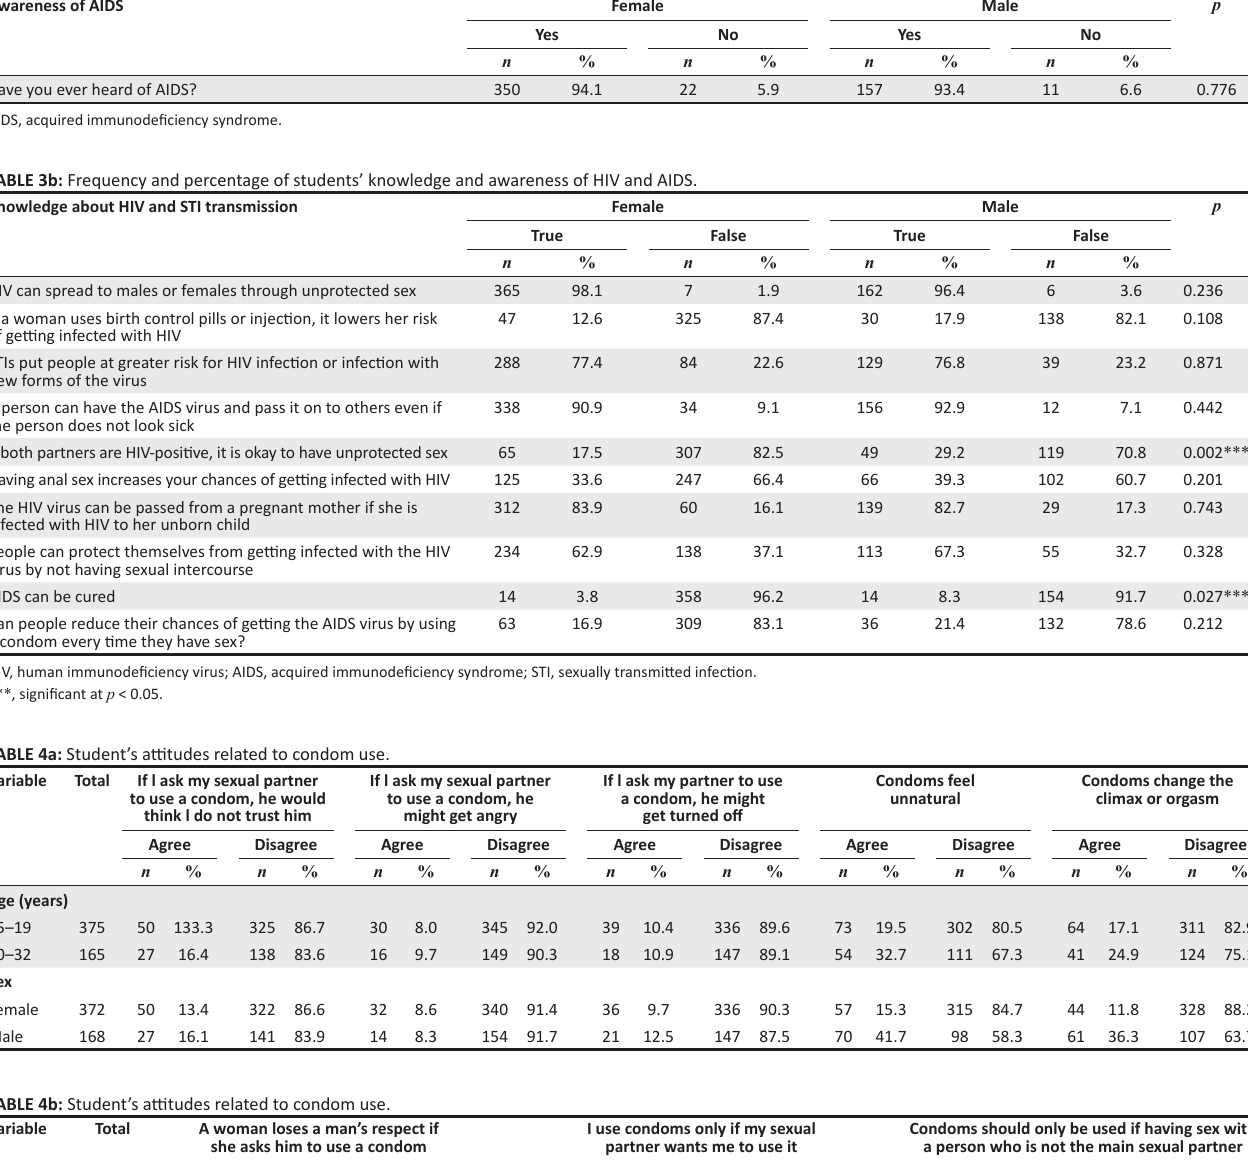
TABLE 3a: Frequency and percentage of students’ knowledge and awareness of HIV and AIDS. Awareness of AIDS